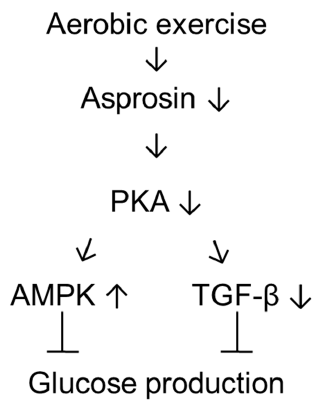
Figure 5. Schematic diagram of the possible mechanisms activated by asprosin in the liver of type 1 diabetic rat following aerobic exercise training.